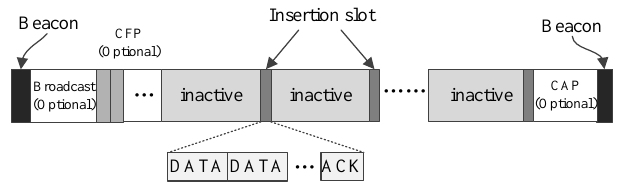
Figure 2. The basic superframe structure of low duty cycling MAC (LDC-MAC).